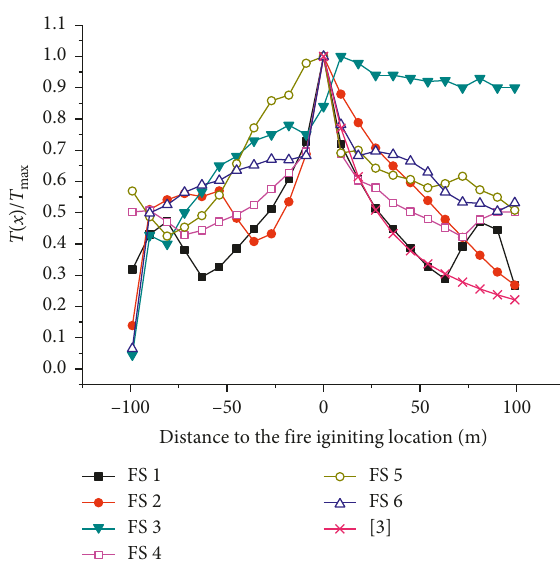
Figure 10: The maximum ceiling temperature along the tunnel.